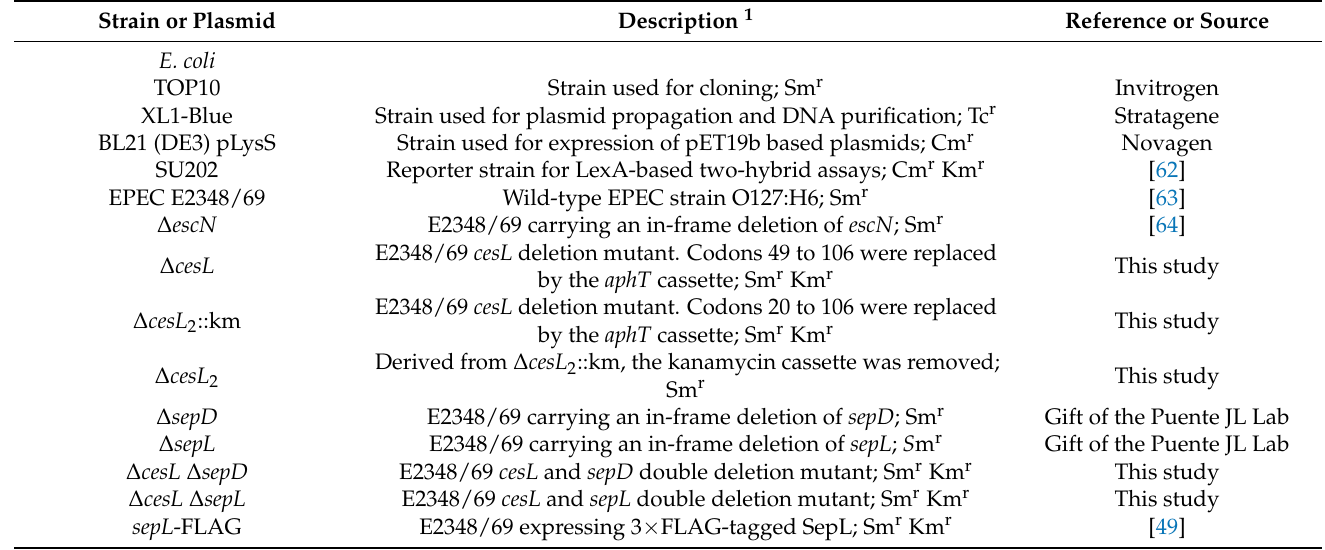
Table 1. Strains and plasmids used in this